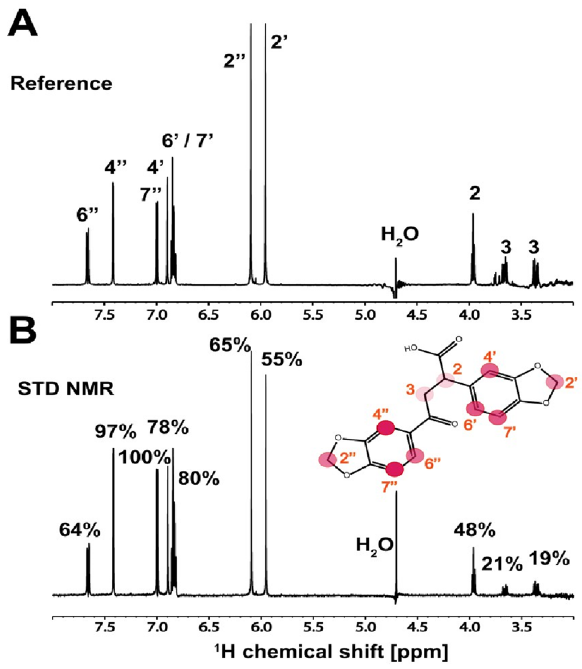
Figure 4. 1 H STD-NMR experiment of 7.44 binding to NHR2. (A) Reference spectrum of 7.44 . Assignment of the individual peaks is indicated (see 7.44 structure in the bottom panel). ( B) 1 H STD-NMR spectrum of ligand 7.44 in the presence of NHR2. Relative intensities are indicated on top of the corresponding peaks and mapped onto the structure of 7.44 . The circles are colored by the relative intensity of the protons, which is correlated with the proximity to the protein: red—100% (the closest), lighter red—97% to 64%, faded red—48% to 19%. The proton numbering is indicated by the red numbers. Data was acquired at 600 MHz and 298 K, with a 100-fold molar excess of 7.44